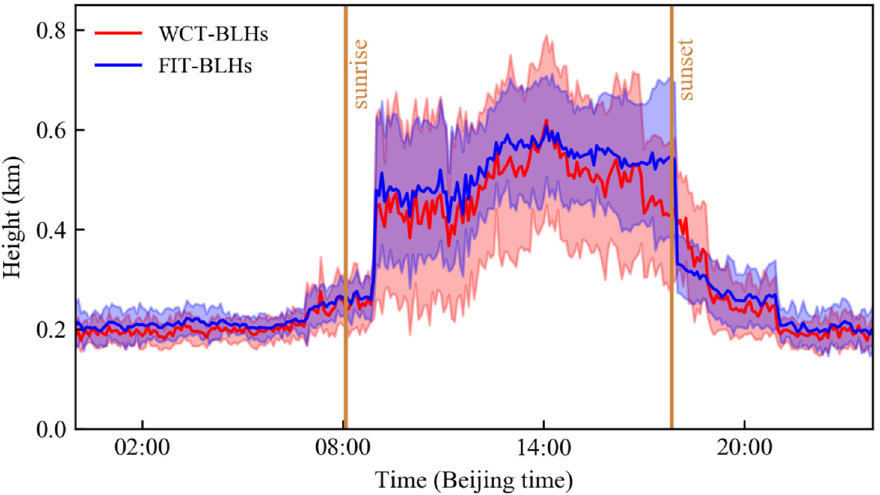
Figure 7. Diurnal variations in lidar-BLHs (average and standard errors) during the observation period.